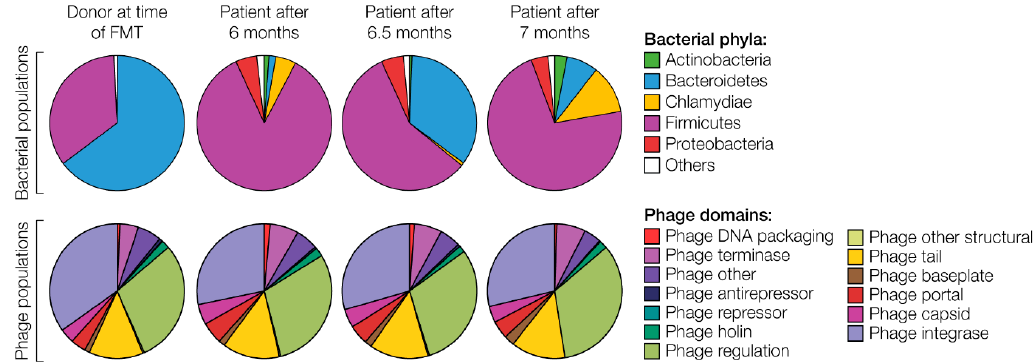
Figure 2. Dynamics of bacterial (top) and phage (bottom) populations in a C. difficile patient successfully treated by fecal microbiota transplantation (FMT). Data adapted from [30].